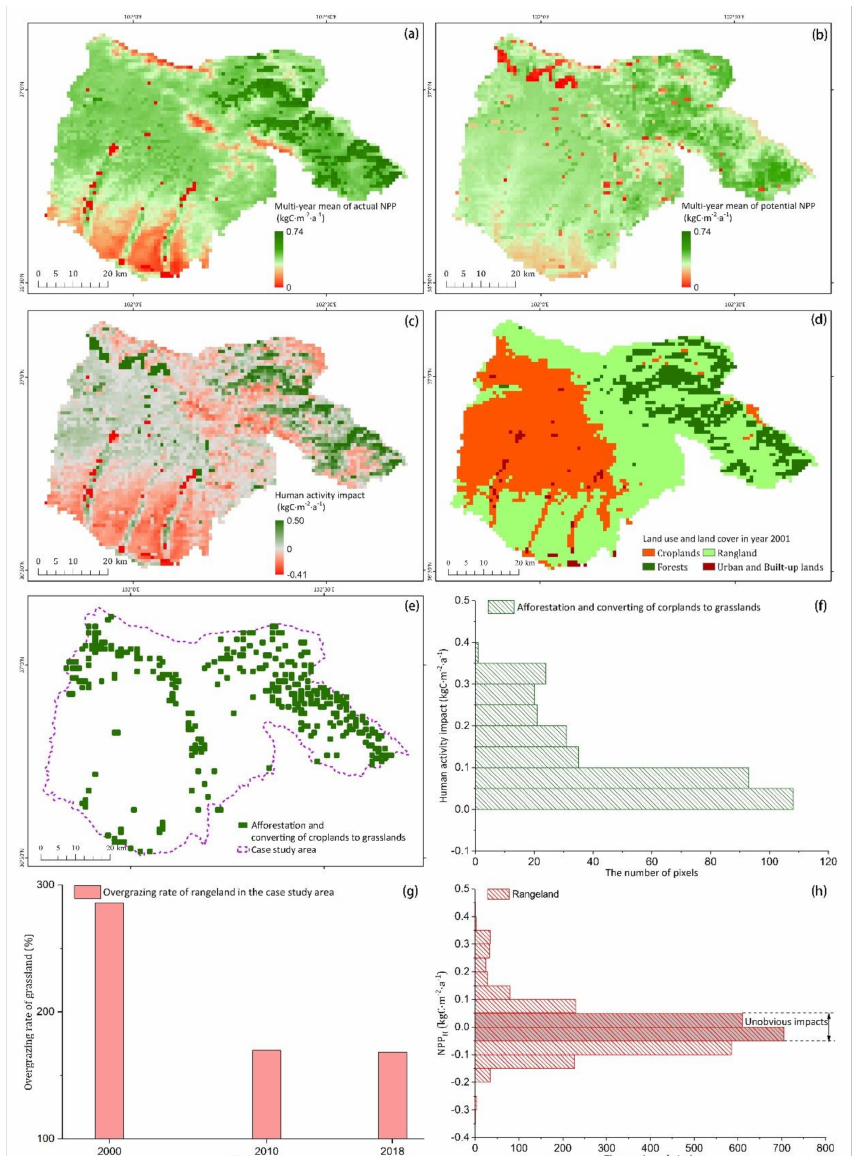
Figure 5. Spatial pattern of NPP and the impact of human activities in the case study area during the period 2000–2017: ( a ) Spatial distribution of the multi-year mean values of actual NPP, ( b ) potential NPP and ( c ) NPP changes caused by human activities (i.e., the impact of human activity) across the full assessment period. ( d ) Land use and land cover in the year 2001. ( e ) Afforestation areas and ( f ) frequency distribution histogram of the impact of human activity there. ( g ) Overgrazing rate of rangelands in the case study in 2000, 2010 and 2018. ( h ) Frequency distribution histogram of the impact of human activity in the